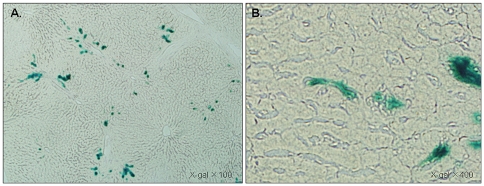
LacZ-positive BM-MSCs distributed around the periportal area.Photomicrograph of liver sections stained with X-gal from a rat 6 h after reflow. A. LacZ-positive MSCs (blue) detected around the periportal area. B. MSCs detected in the sinusoid (right panel).